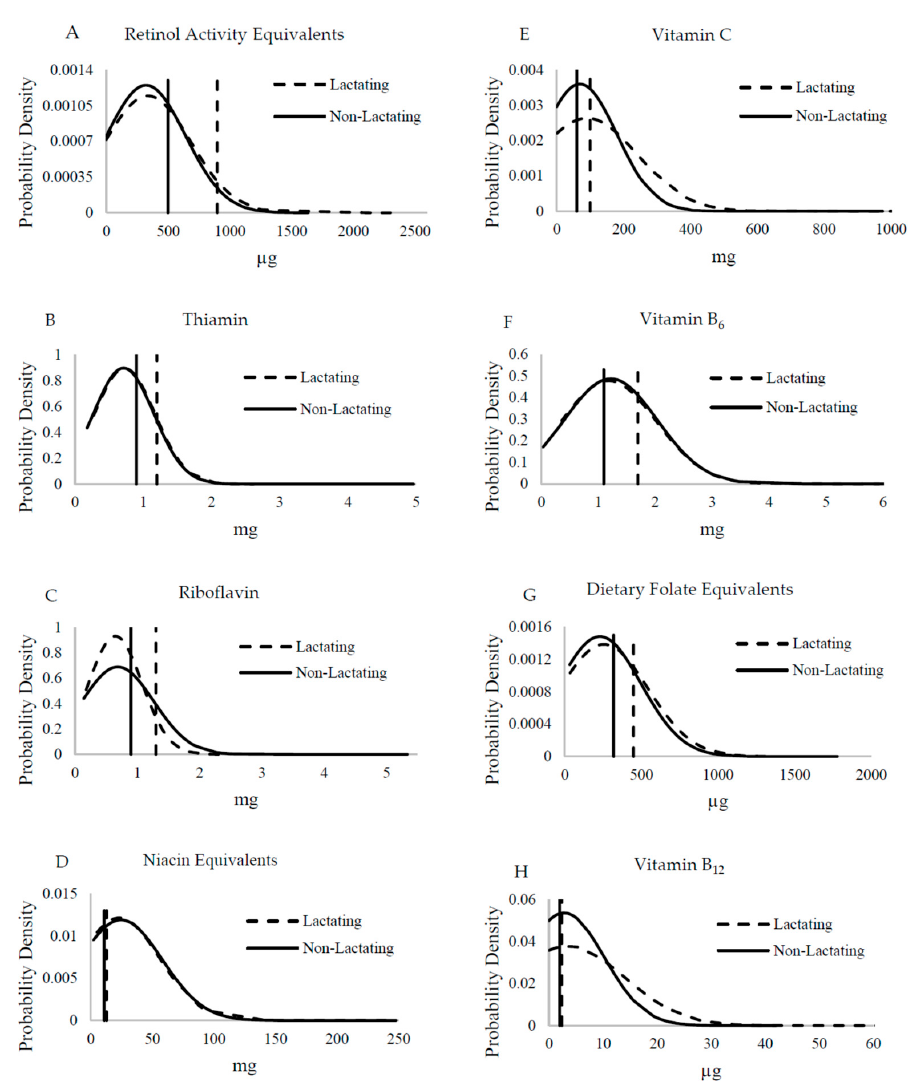
Figure 3. Overlaid vitamin intake distributions from lactating ( n = 180, dashed curved line) and non-lactating ( n = 342; solid curved line) women assessed by 24-h dietary recall for vitamins of interest in comparison with the estimated average requirements (EARs). Two-sample t -tests were used to compare mean intake differences for each vitamin: ( A ) vitamin A ( p = 0.62), ( B ) thiamin ( p = 0.69), ( C ) riboflavin ( p = 0.42), ( D ) niacin ( p = 0.65), ( E ) vitamin C ( p = 0.06), ( F ) vitamin B 6 ( p = 0.65), ( G ) folate ( p = 0.29), and ( H ) vitamin B 12 ( p = 0.38). Vertical lines represent EARs for vitamins for lactating women (dashed line) and non-lactating women (solid line).